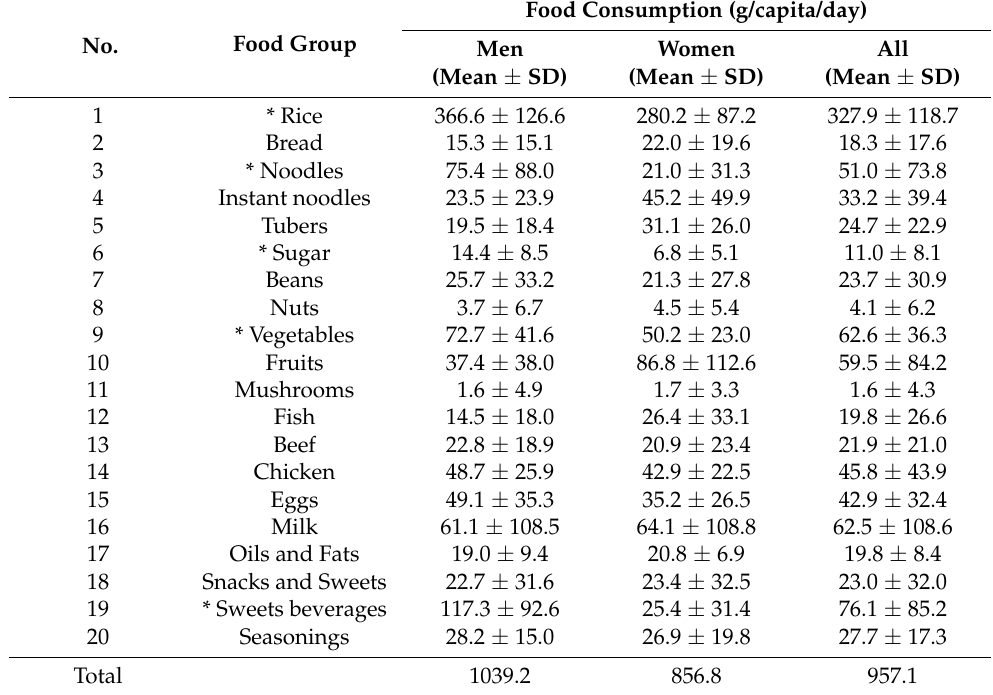
Table 6. Food consumption pattern of observed